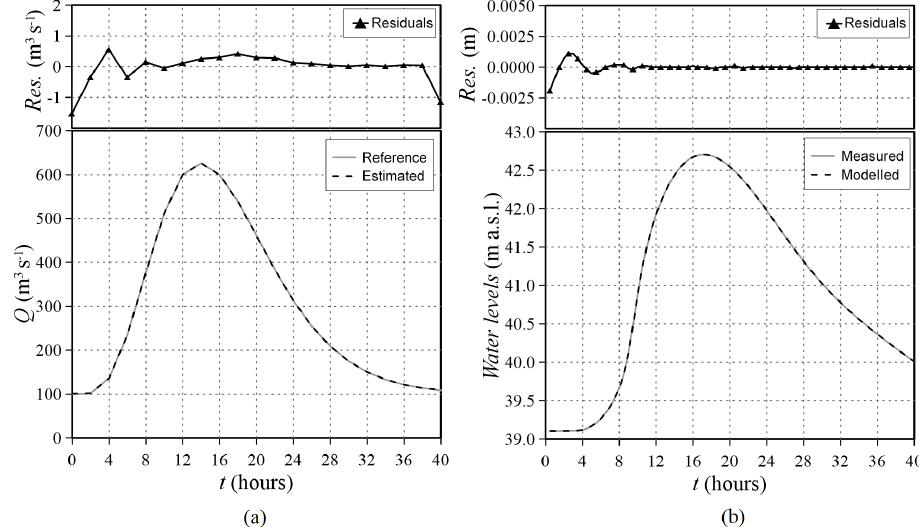
Figure 9. Parma River: reference and estimated inflow hydrograph (a) and observed (uncorrupted) and modelled water levels (b) . The residuals between reference and estimated values are also